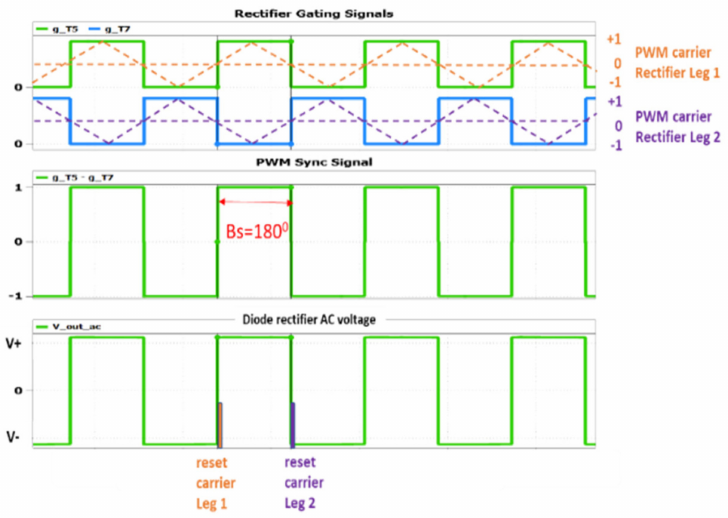
Figure 29. DAB smooth startup transition stage (1): phase shift angle δ (deg) auto-adjustment for rectifier PWM modulator smoothly enabled in diode rectifier operation